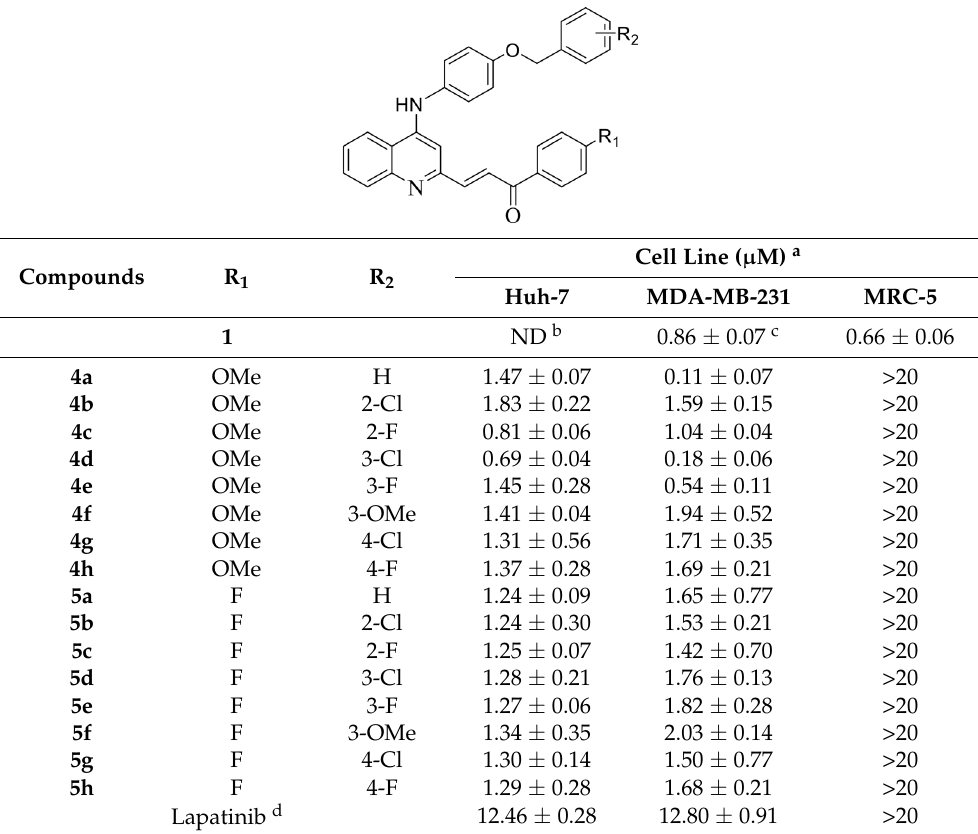
Table 1. IC 50 values of 4-anilinoquinolinylchalcone derivatives in cancer and normal cell lines.